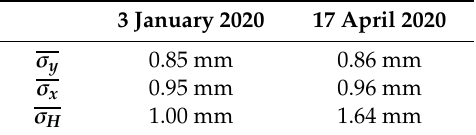
Table 1. Average precision of the adjusted